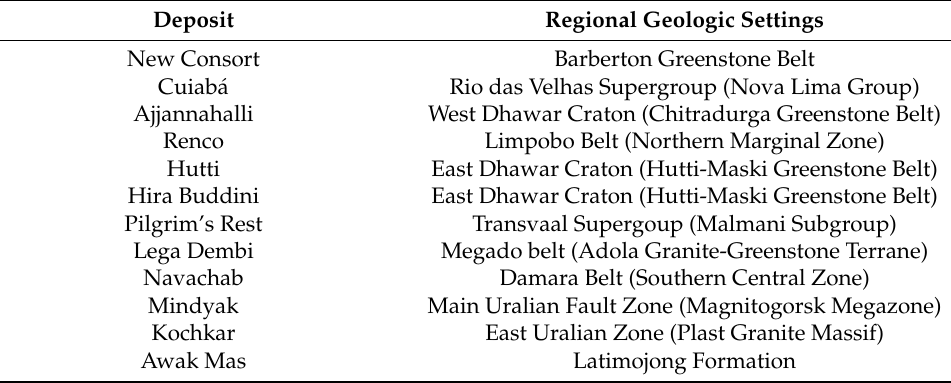
Figure 1. Geographic distribution of gold deposits studied. Table 1. Regional geologic settings of hosts to the